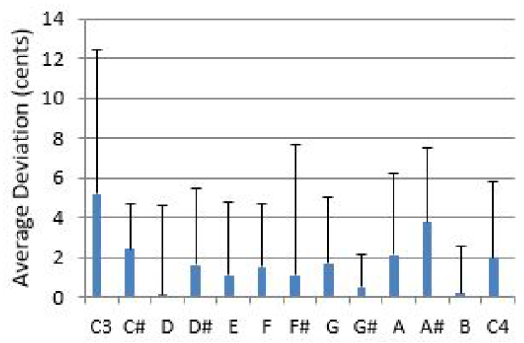
Fig. 16. Group II’s note